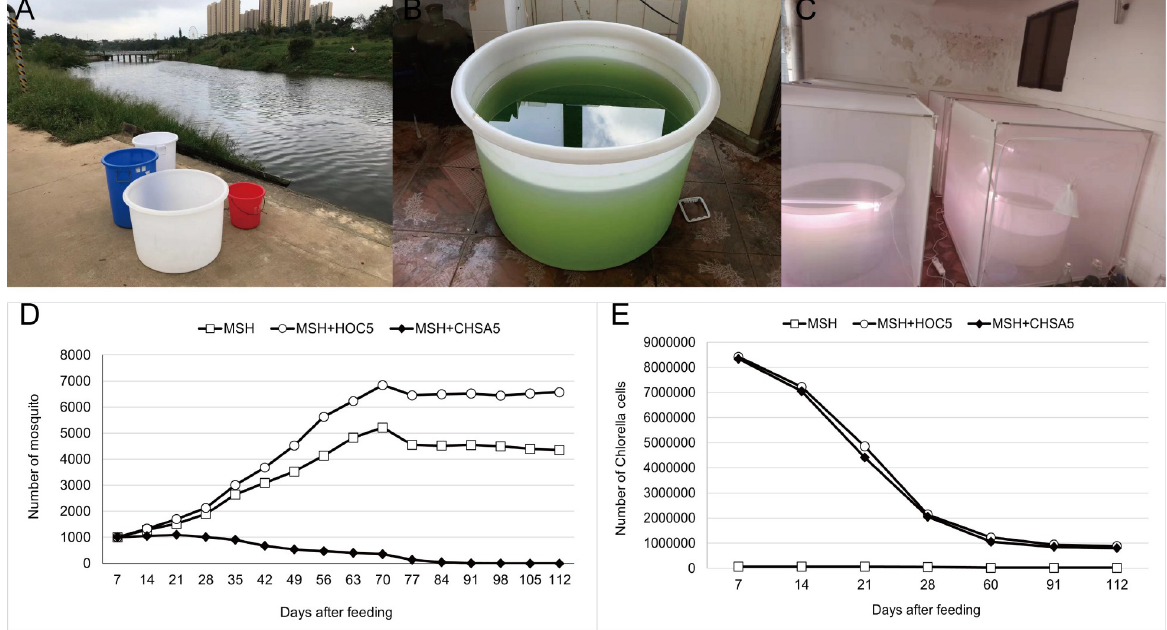
Fig 5. Simulated-field trials in suburban Haikou. The test water from Meishe river (A). 200 L Chlorella mixed with 600 L of the Meishe river water in the barrel (B). Approximately 1000 L1 larvae were placed in each cage, and the number of adult Aedes mosquitoes was counted once a week (C). Population and survival rates of Ae . albopictus in MSH, MSH+HOC5, and MSH+CHSA5 treatments (D). The relative abundance of Chlorella in MSH, MSH+HOC5, and MSH+CHSA5 waters (E). MSH: The mosquito was living in water from the Meishe river alone. MSH +HOC5: The mosquito was living in water from the Meishe river supplemented with wild Chlorella HOC5. MSH+CHSA5: The mosquito was living in water from the Meishe river supplemented with recombinant Chlorella